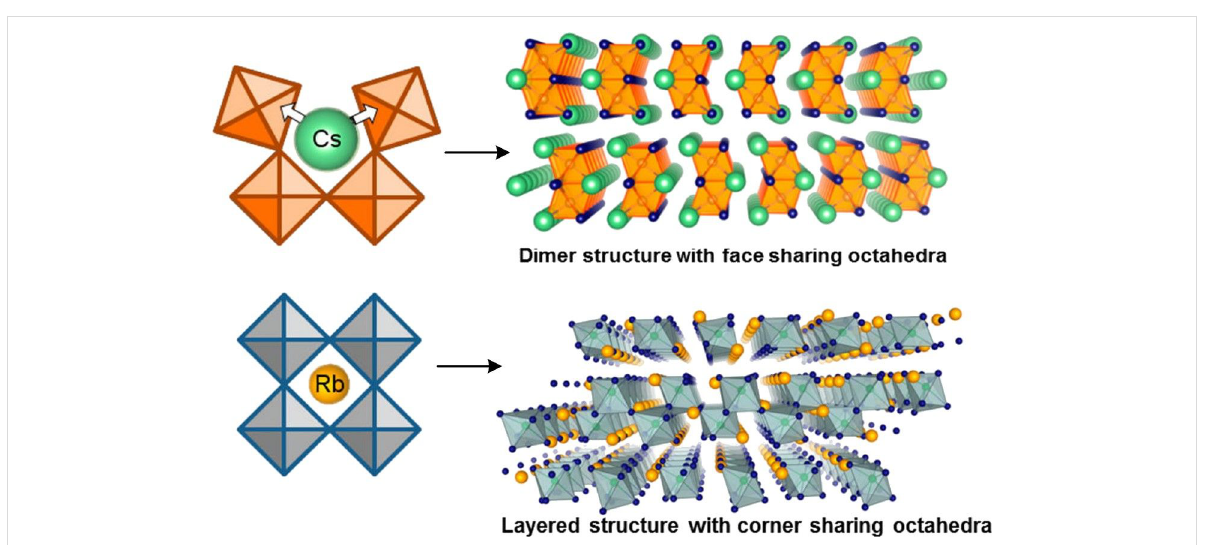
Figure 13: Schematic of the influence of the cation size on the structure of A 3 Sb 2 I 9 (A = Cs, Rb). Reprinted and adapted with permission from [91], copyright 2016 American Chemical